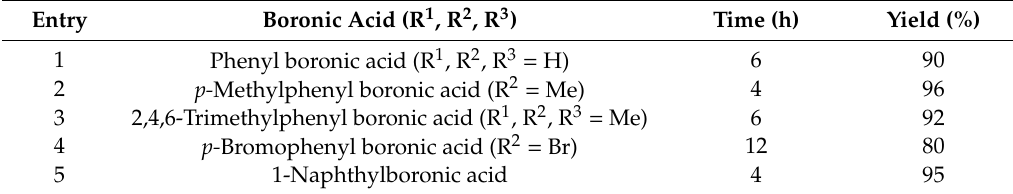
Table 2. Co-catalyzed oxidation of substituted phenyl boronic acids.